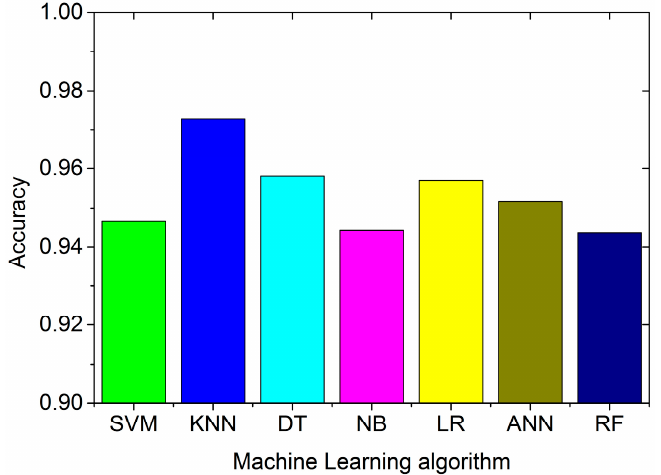
Figure 11. Classification accuracy using four stations’ signal strength with different classifiers created by different machine learning algorithms.